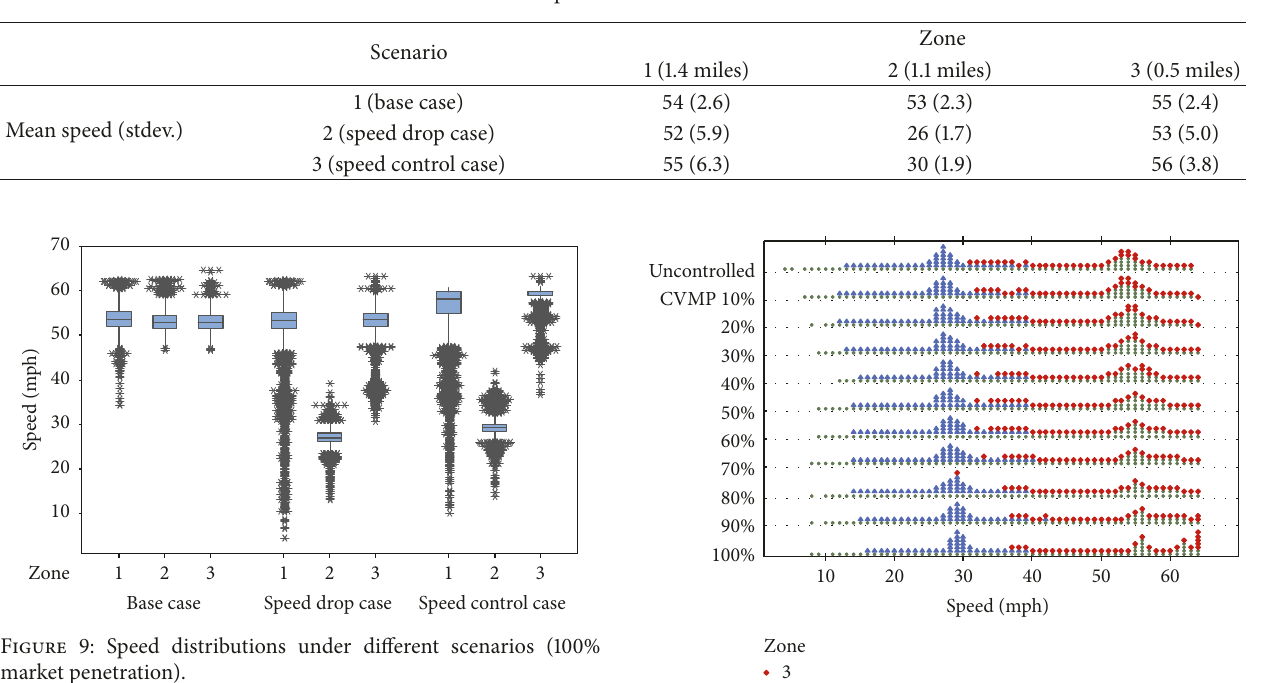
Table 3: Mean speeds under different scenarios.